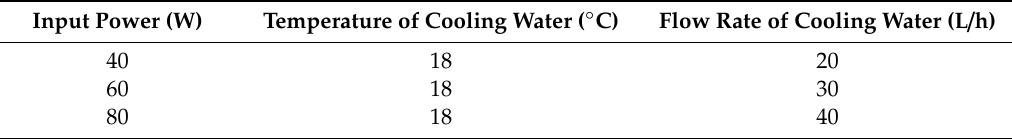
Figure 3. Image of the real thermosyphon used in the experiments. Table 1. The boundary conditions of the